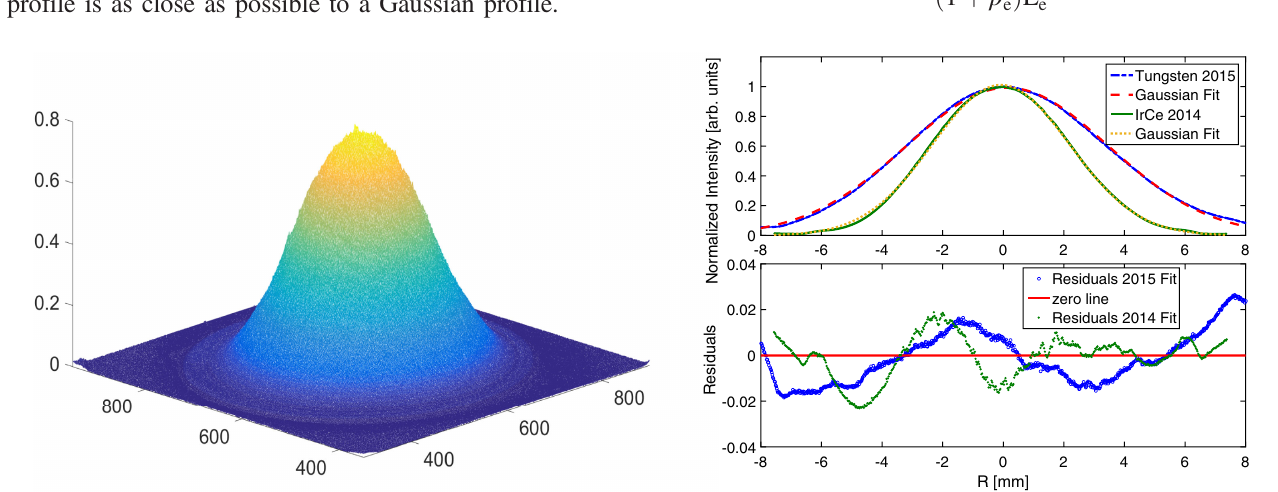
FIG. 5. Transverse beam profile